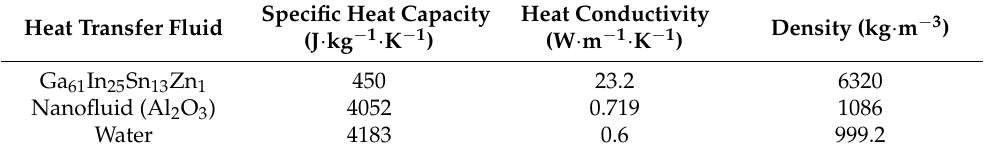
Table 2. Comparison of the properties of various heat transfer fluid [21,24].